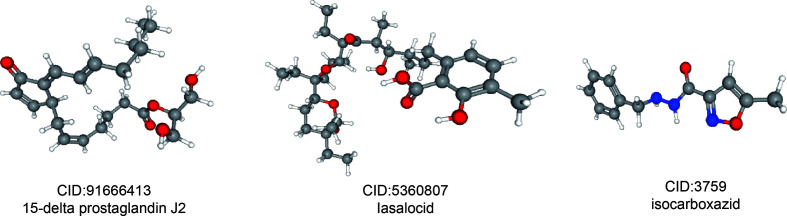
3D conformer of four most significant small molecule drugs.